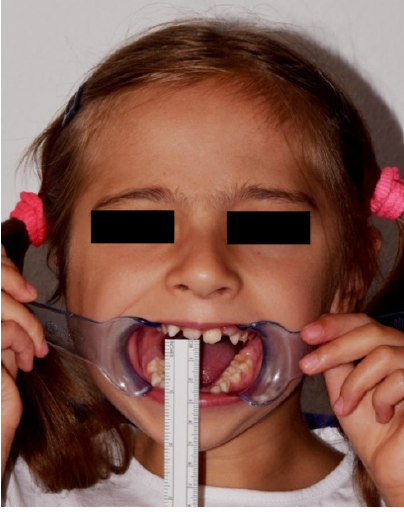
Figure 9. MMO of 25 mm 6 months after TMJ prosthetic replacement.